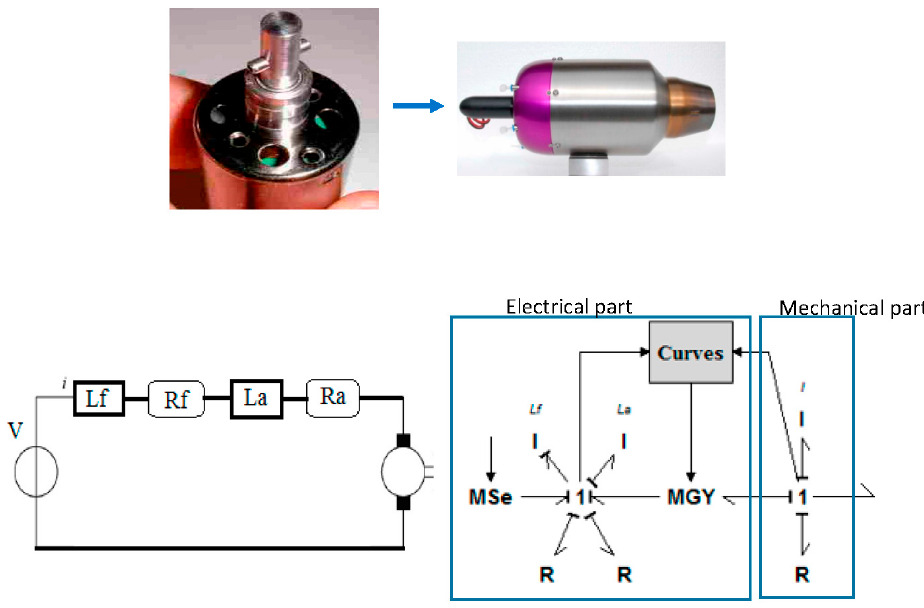
Figure 4. Electric starter, circuit, and the bond graph model [14]. Table 4. Characteristics of a DC starter motor.